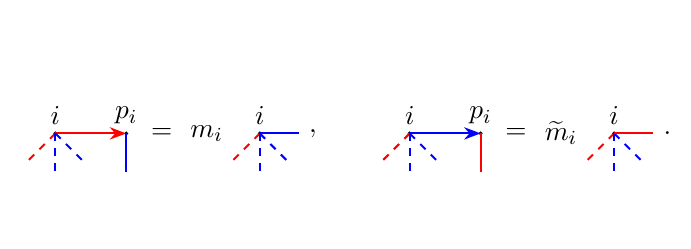
and M . We are showing both 1 2